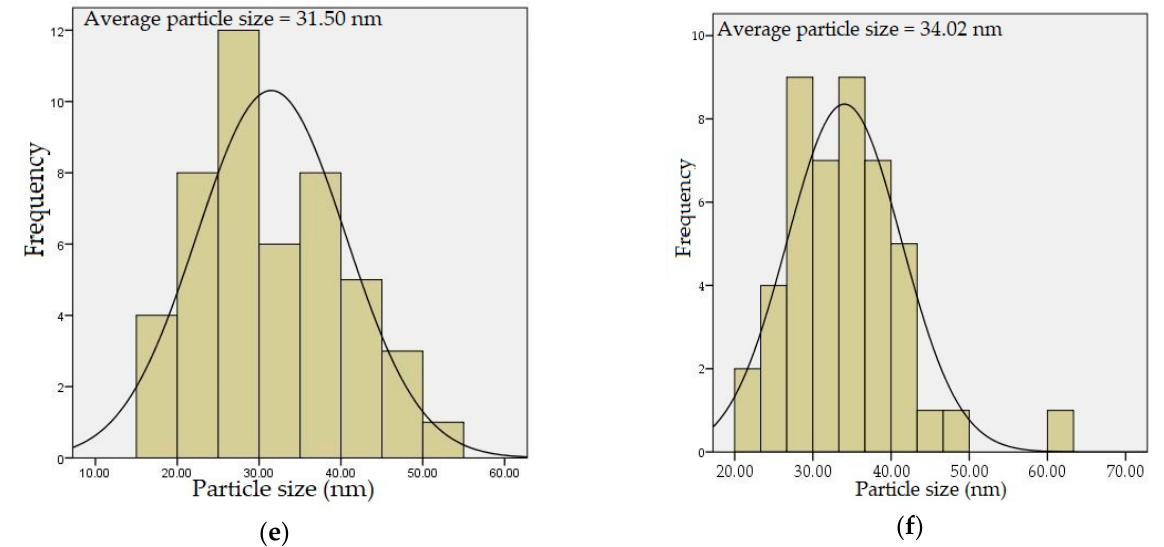
Figure 10. Willemite NPs size distribution calcined at 900 °C with different Ce 3+ doping concentrations; ( a ) 0 mol%, ( b ) 1 mol%, ( c ) 2 mol%, ( d ) 3 mol%, ( e ) 4 mol%, and ( f ) 5 mol%.